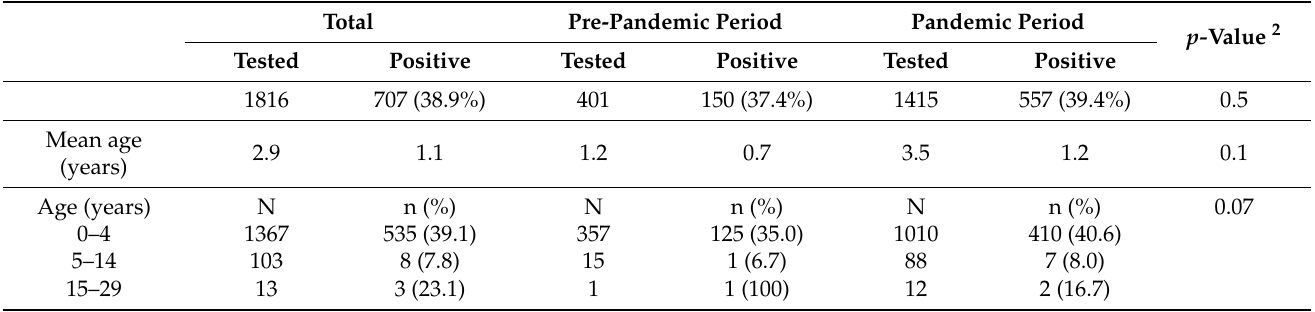
Table 3. Characteristics of RSV-positive cases detected among patients enrolled through the Influenza Surveillance Network, Madagascar from January 2018 to May